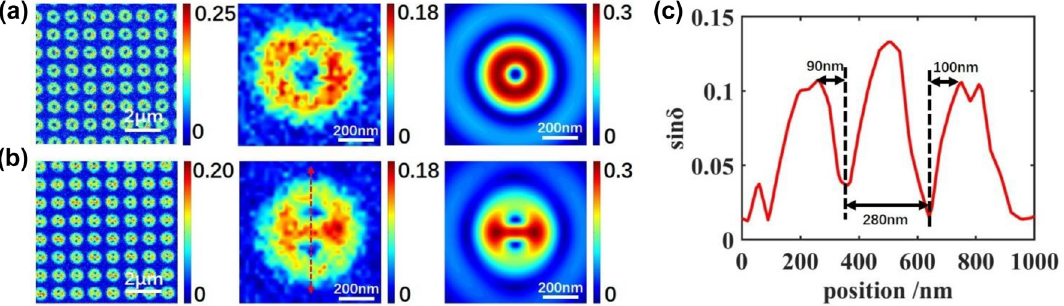
Figure 4: Sin 𝛿 images for (a) ring under 560 nm wavelength, and (b) split-ring under 540 nm wavelength. From left to right: large scale experimental results, single nanodot result, simulated single nanodot result. (c) Value of the spatial curve along red line in